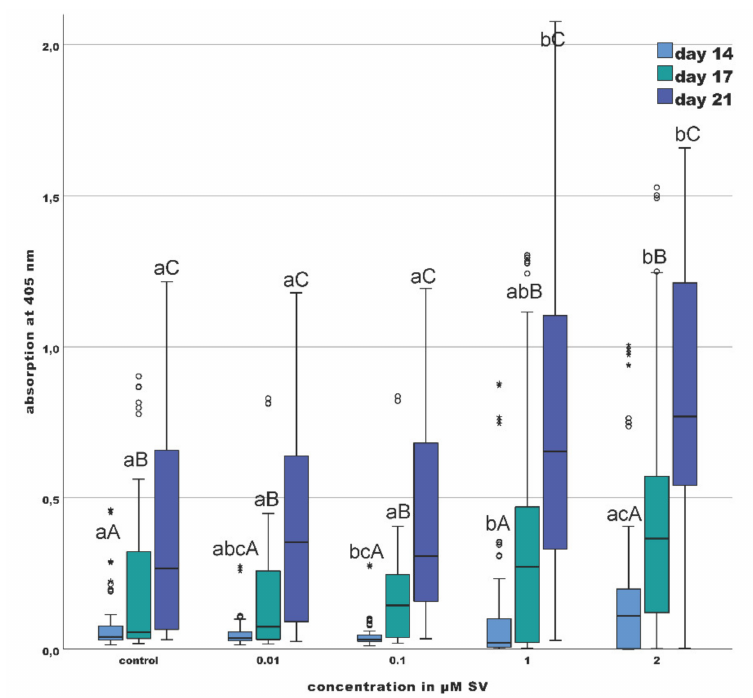
Figure 4. Mineralization given as photometric absorption at λ 405 nm of the alizarin red S staining; (di ff erent letters indicate statistically significant di ff erences at p < 0.05 within the day (capitalized) and concentration (uncapitalized)); (the upper and lower whiskers shows the maximum and minimum values, the box represents 50% of the values and the horizontal line within the box displays the median